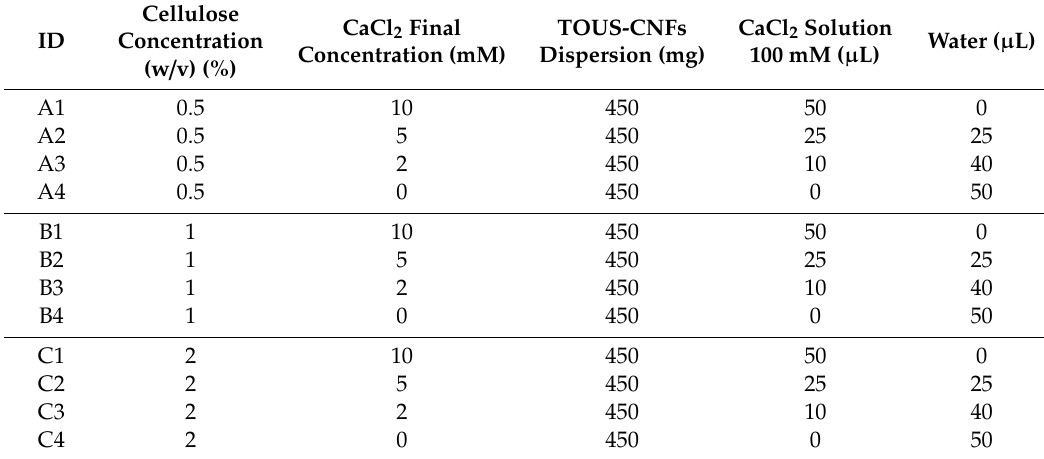
Table 2. Samples of TOUS-CNFs / Ca 2 + stock